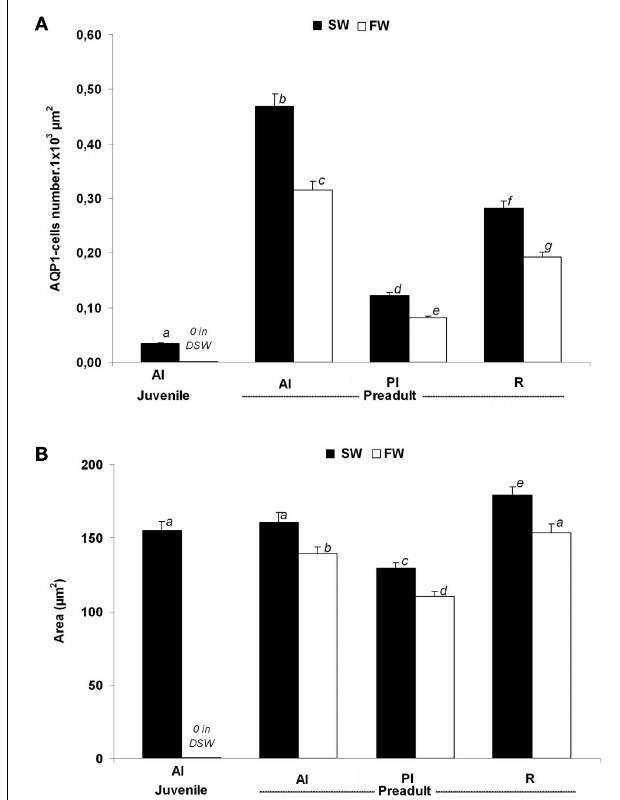
FIGURE 8 | Dicentrarchus labrax. Morphometric analysis of AQP1a-cells in selected organs of juvenile (D96) and 2-year-old pre-adult sea-bass acclimated to SW and DSW or FW.The number of AQP1a-cells (A) and their surface area (B) are shown.Values are mean ± standard error. Different letters indicate significant differences between values ( p < 0.05, n = 6). AI, anterior intestine; PI, posterior intestine; R, rectum; SW, sea water; DSW, diluted sea water; FW, fresh